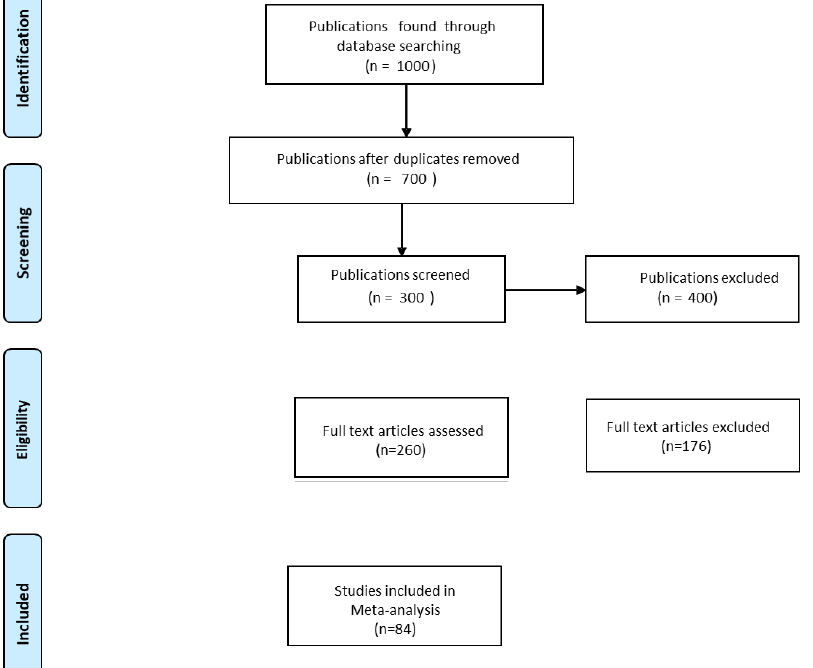
Figure 1. Flow diagram of meta-analysis.